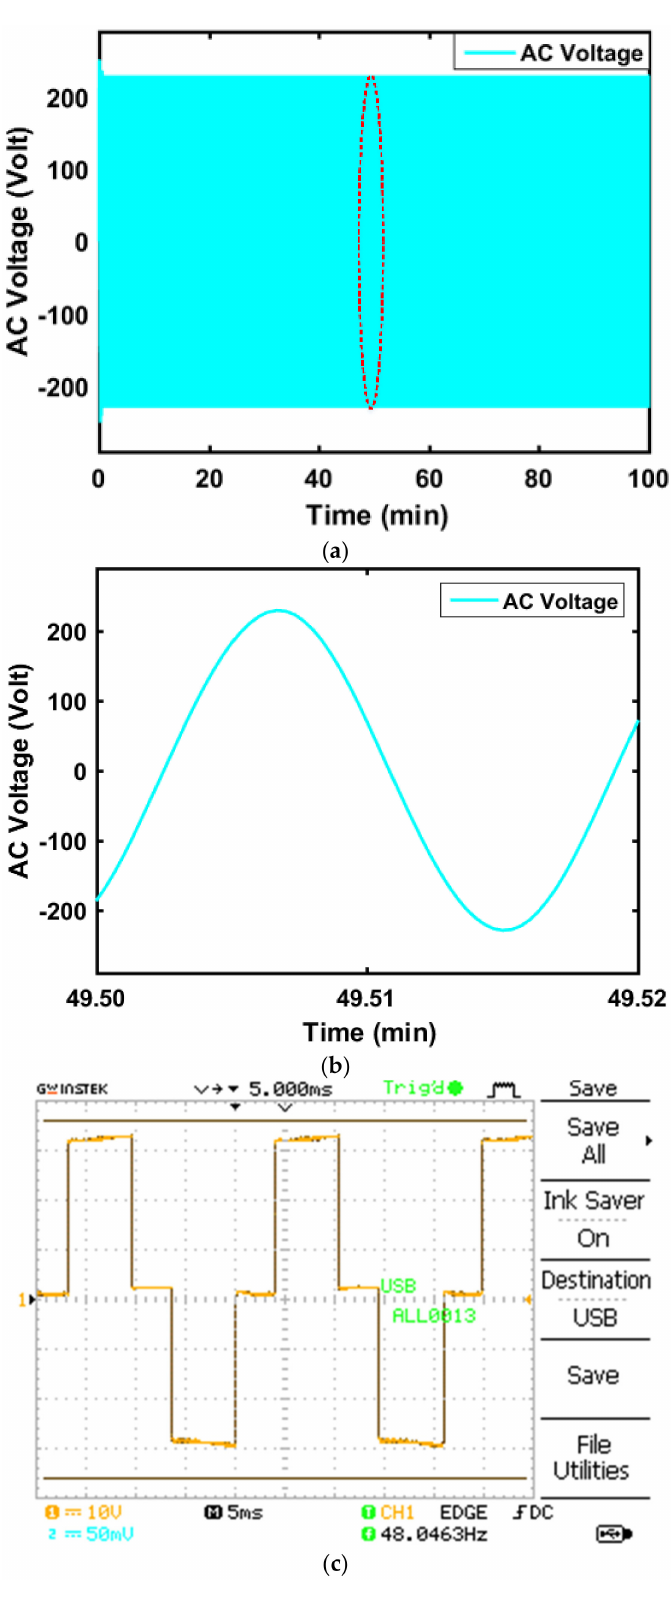
Figure 7. ( a ) AC voltage density, ( b ) Pure AC sine wave, and ( c ) Modified AC sine wave view on